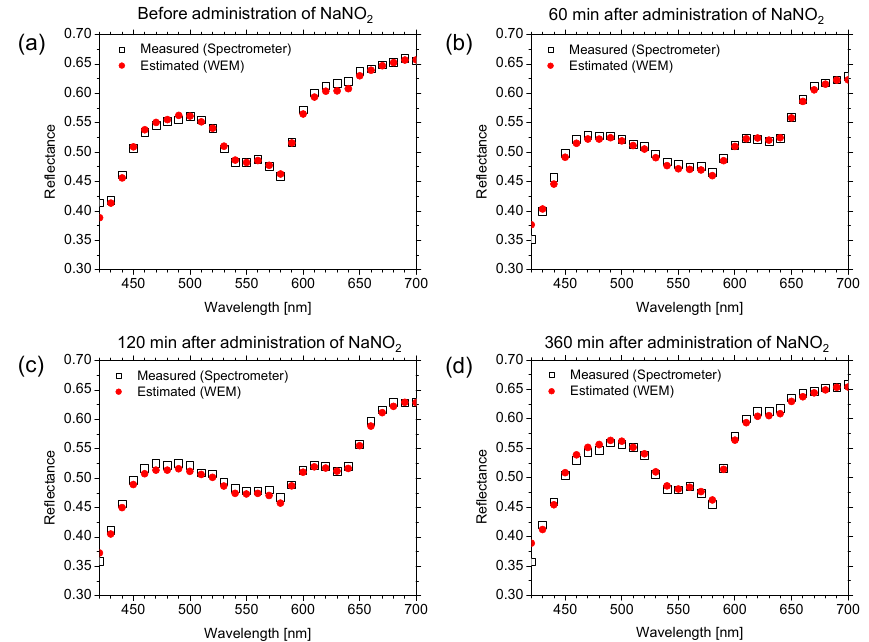
Figure 3. Comparisons of estimated reflectance spectra averaged over entire region of spectral images and reference spectra measured by spectrometer: ( a ) before administration of NaNO 2 , ( b ) 60 min after administration of NaNO 2 , ( c ) 120 min after administration of NaNO 2 , and ( d ) 360 min after administration of NaNO 2 .